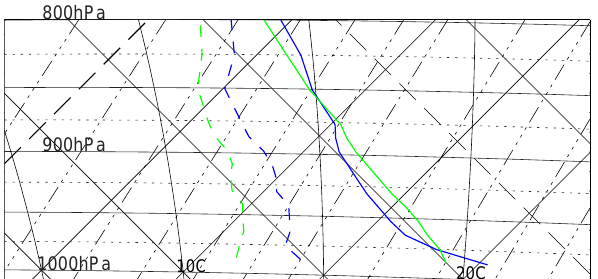
Fig. 12. Tephigram showing profile of temperature (solid line) and dew point (dashed line). Blue and green lines show the profile re- trieved from the radiometer observation at Linkenholt, with a strong lapse rate near the surface at 13:32:42UTC and more stable but drier conditions in the lowest km at 13:52:18UTC. The dew point for the blue line corresponds closely to the radiosonde measure- ments at Larkhill at 12:00 and 15:00UTC.